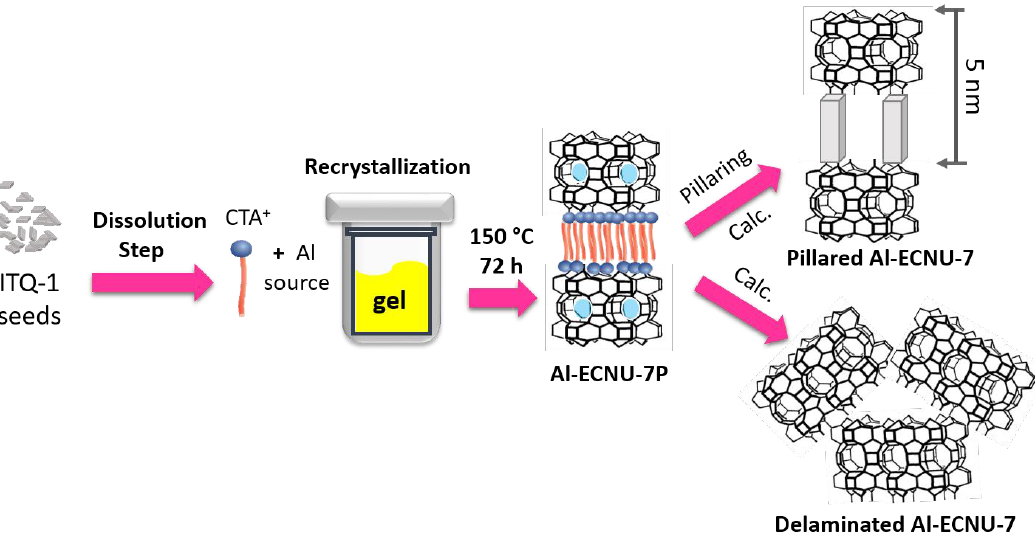
Figure 9. General scheme of the synthesis of Al-ECNU-7P as well as its pillared and delaminated forms.